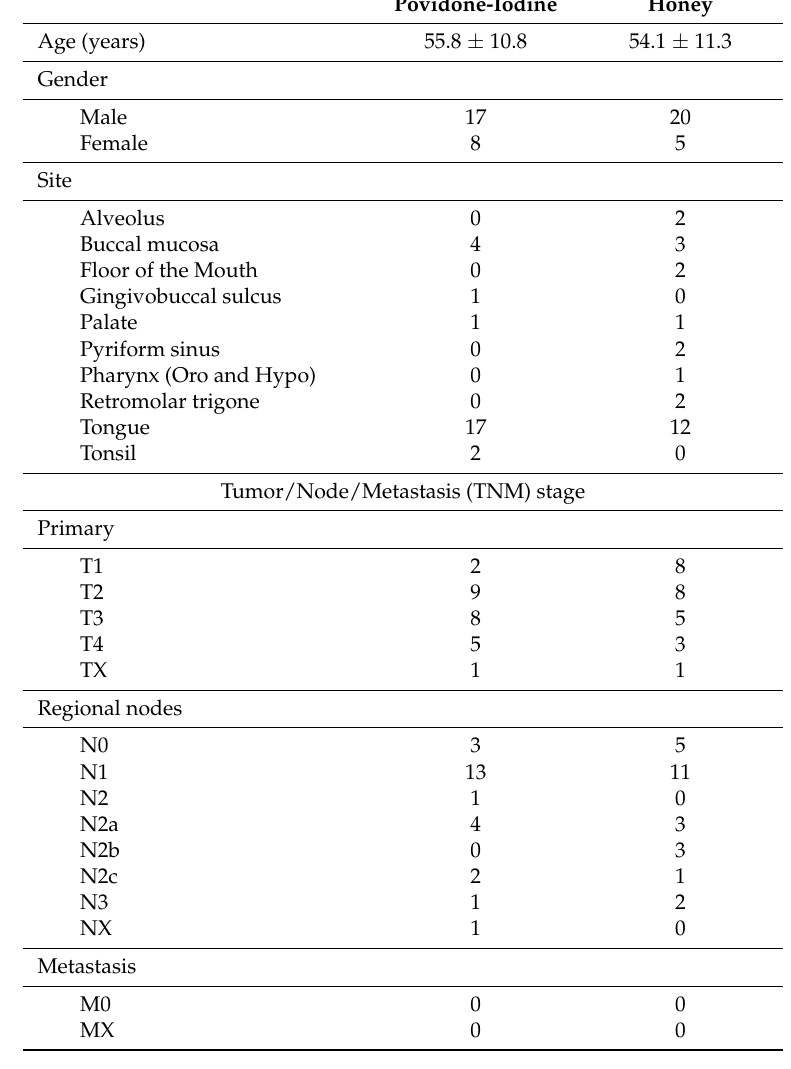
Table 2. Treatment details and clinical end